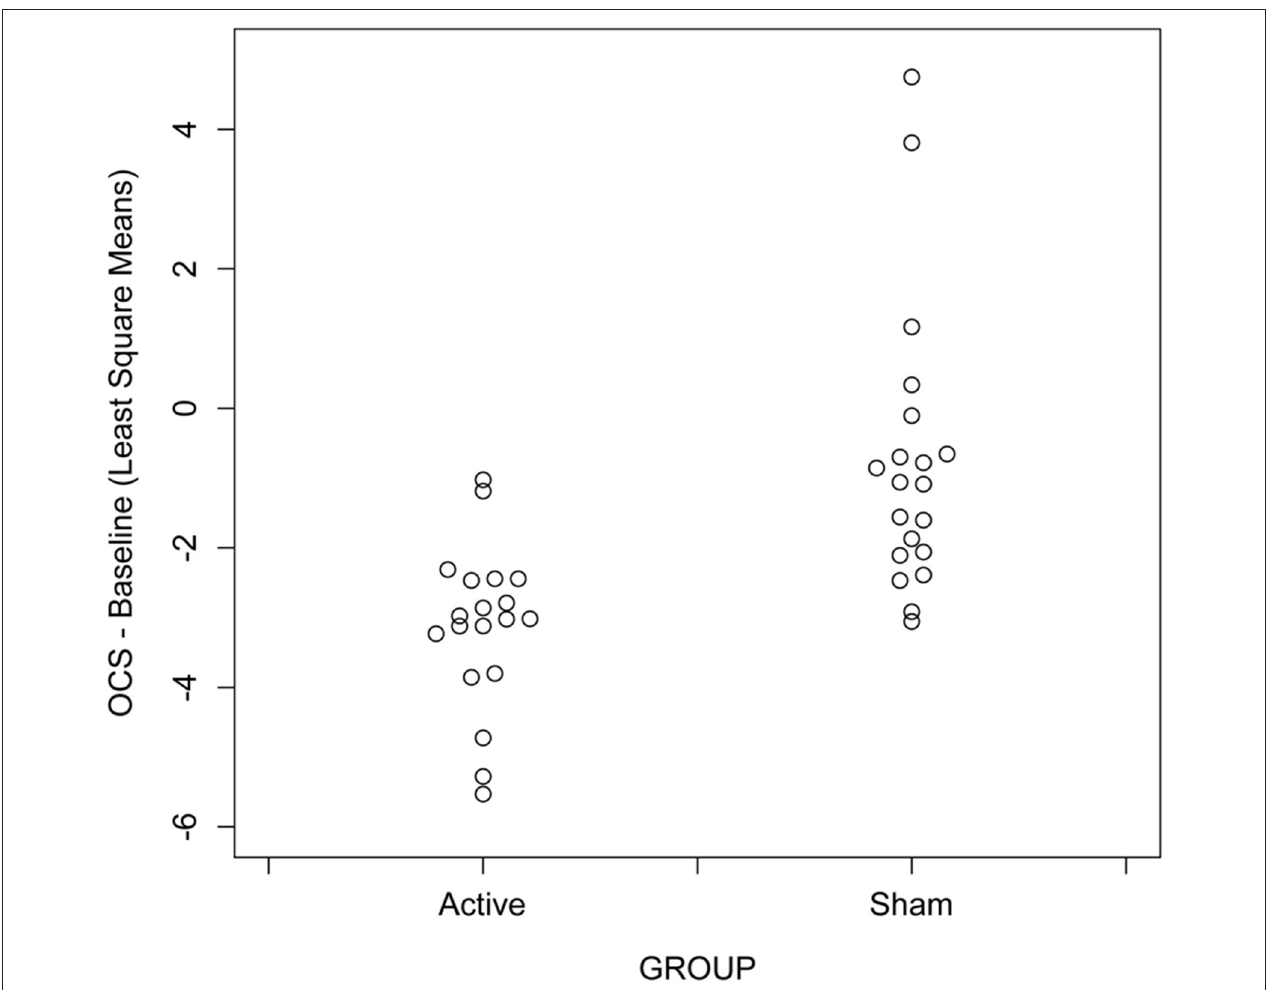
The participants’ demographic information is presented